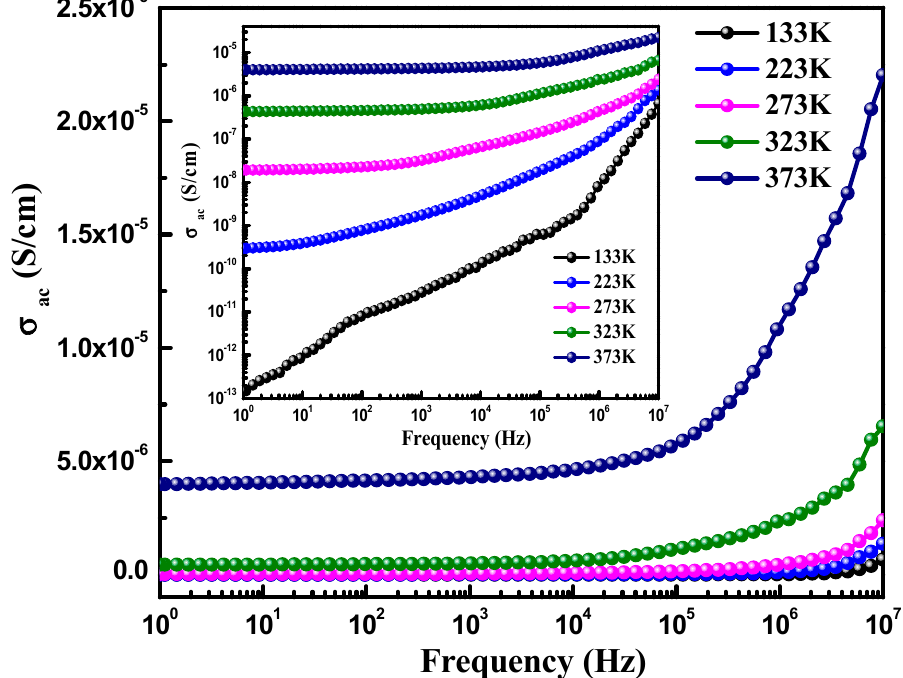
Figure 7. σ ac versus frequency curve of CeFe 2 O 4 nanostructures at different temperatures. Inset shows log ( σ ac ) versus log (frequency) curve of CeFe 2 O 4 nanostructures at different temperatures.